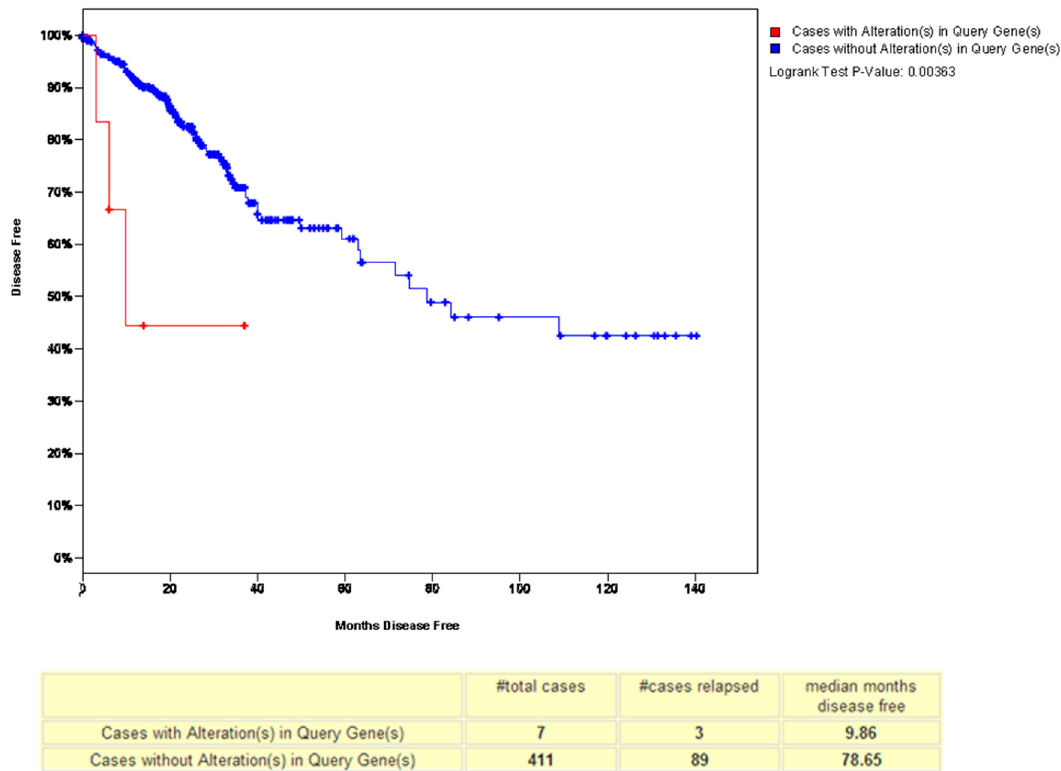
Figure 12. GLOI overexpression shortened disease-free survival in a reference patient cohort from www.cbioportal.org. The red line represents GLOI overexpression levels, the blue line represents GLOI low expression levels